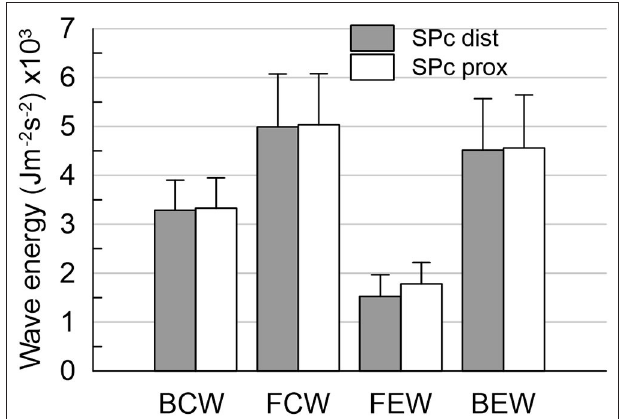
FIGURE 5 | Wave energies at distal location in diseased vessels after PCI. The wave energies are equivalent, whether derived from wave intensity profiles separated with local SPc assessed at proximal or distal locations. Note: proximal values are pre-PCI data in this subset of patients.